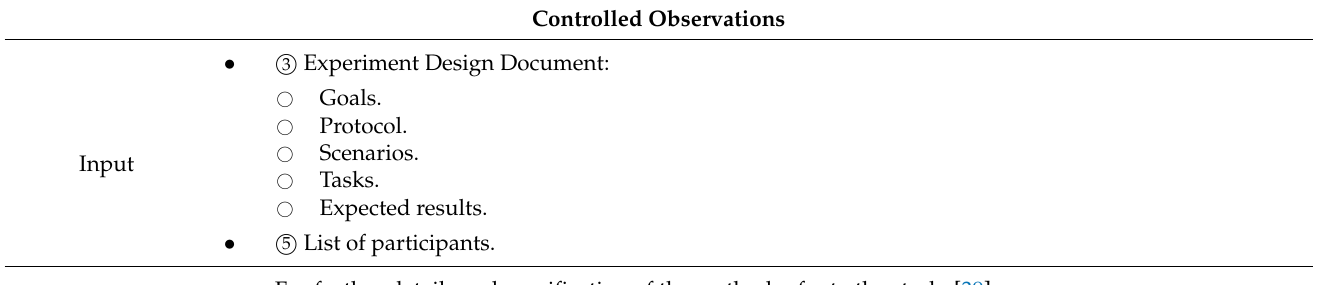
Table A13. Controlled Observations Specification. Controlled